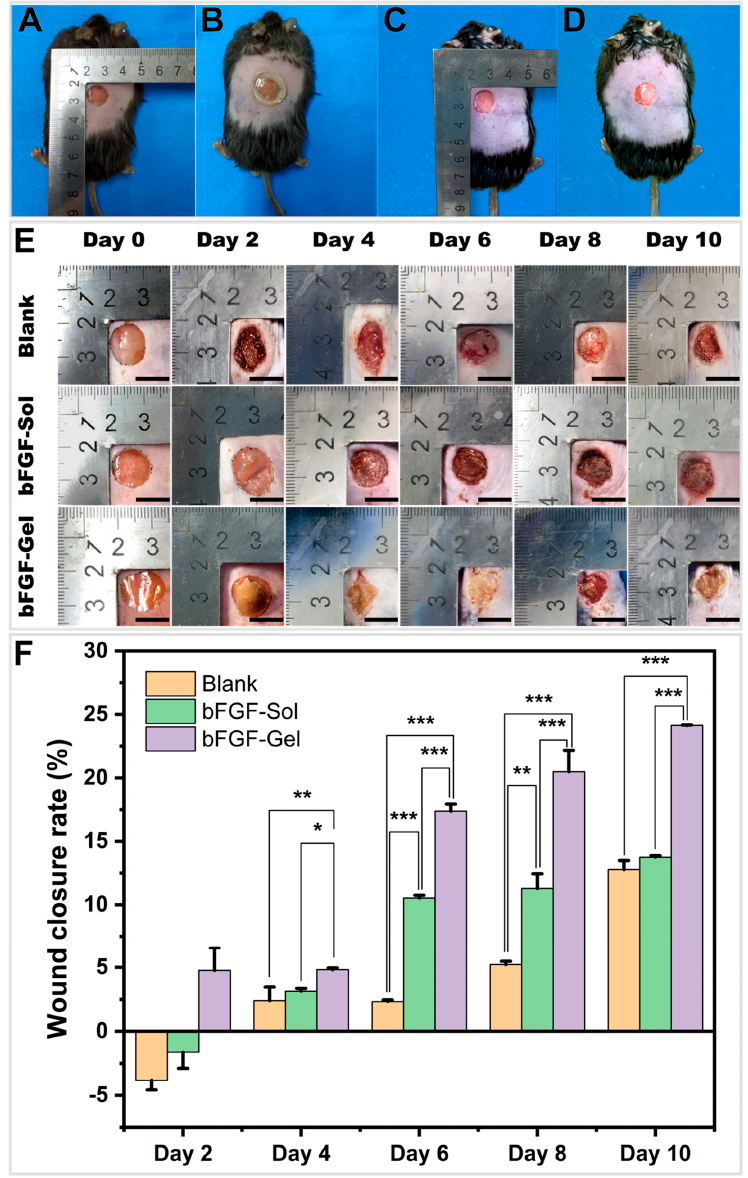
Figure 3. The evaluation of chronic wound healing on the aged mouse. ( A ) Full-thickness skin wound of bFGF-Gel group, ( B ) bFGF-Gel dressing covered on the wound, ( C ) Full-thickness skin wound of bFGF-Sol group, ( D ) bFGF was spraying on the wound, ( E ) Digital photos of wounds on the dorsum of mice after treatment by using no treatment (Blank), spraying bFGF-Sol and bFGF-Gel hydrogel dressings on different days after the surgery. ( F ) Summary graph of the wound closure rate of these three groups. The data were represented as mean ± SD ( n = 3). * p < 0.05, ** p < 0.01, *** p < 0.001. Scale bar =10